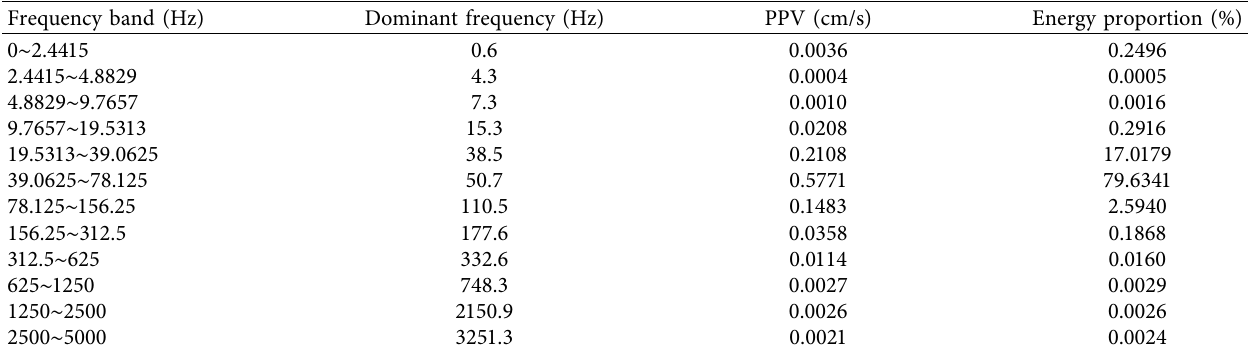
Table 5: Dominant frequency, PPV, and energy proportion of each subfrequency band at measuring point 57 in the medium zone.